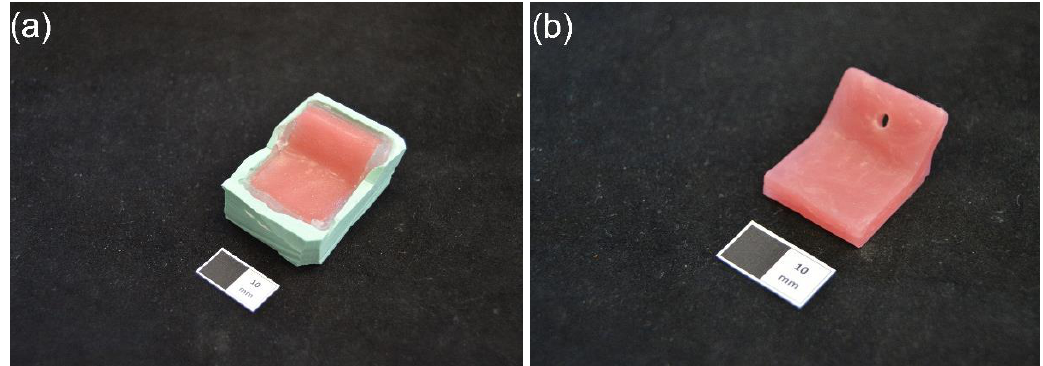
Figure 3. Fabrication of reference test blocks. ( a ) The silicone impression (green) and light-curing resin (red), ( b ) Reference test block (white scale: 10 mm). (red), ( b ) Reference test block (white scale: 10